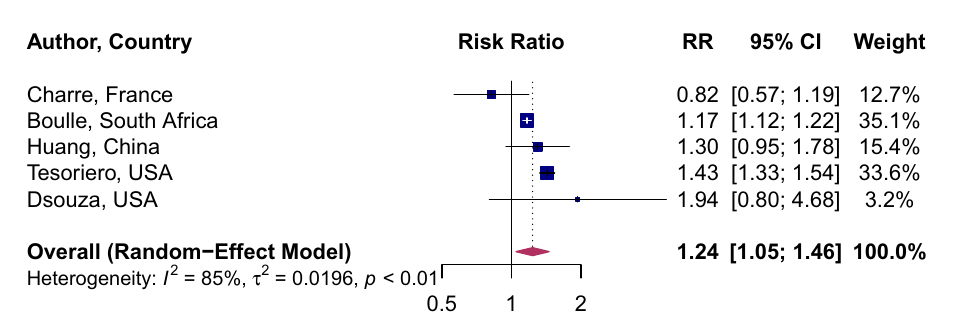
Figure 2. Association of HIV and attack rate of SARS-CoV-2. Blue squares and their corresponding lines are the point estimates and 95% confidence intervals from each study. Maroon diamond represents the pooled effect